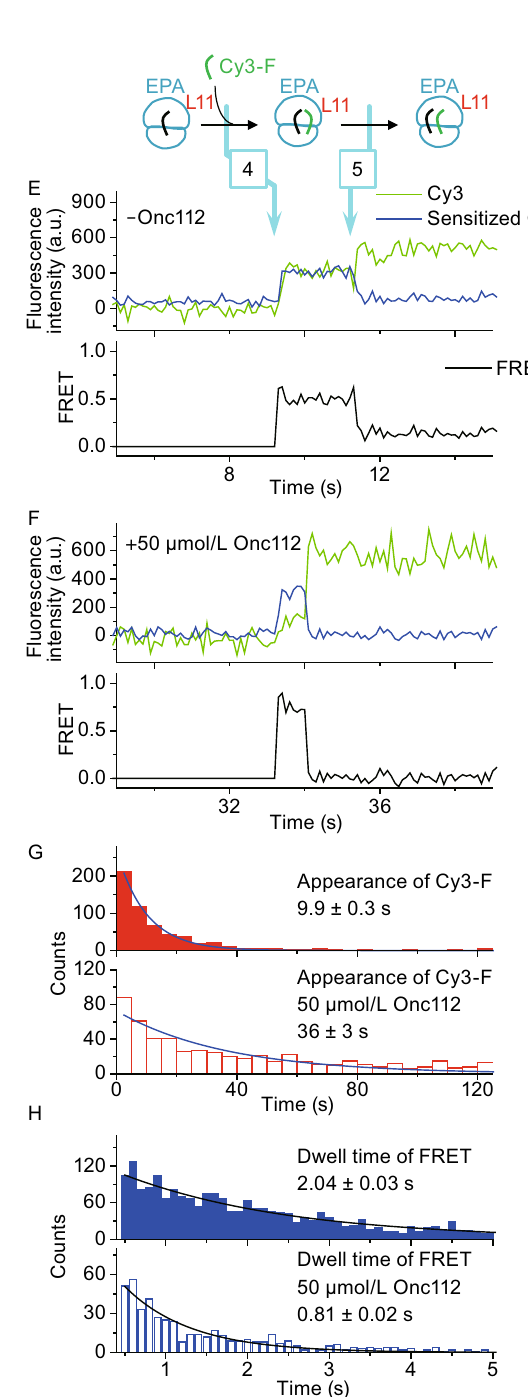
appearance of steady Cy3 and FRET intensities (arrow 4 in Fig. 1E), markedly decreased from 12.6 ± 0.4 s − 1 ( μ mol/L) − 1 to 3.5 ± 0.3 s − 1 ( μ mol/L) − 1 in the presence of Onc112 (Fig. 1G). Onc112 also decreased delivery rates of aa-tRNA in the fi rst elongation cycle (Fig. S5). Our fi ndings agreed with previous speculation derived from structural studies, which proposed that Onc112 could hinder entrance of aa- tRNA into the ribosome (Roy et al., 2015; Seefeldt et al.,